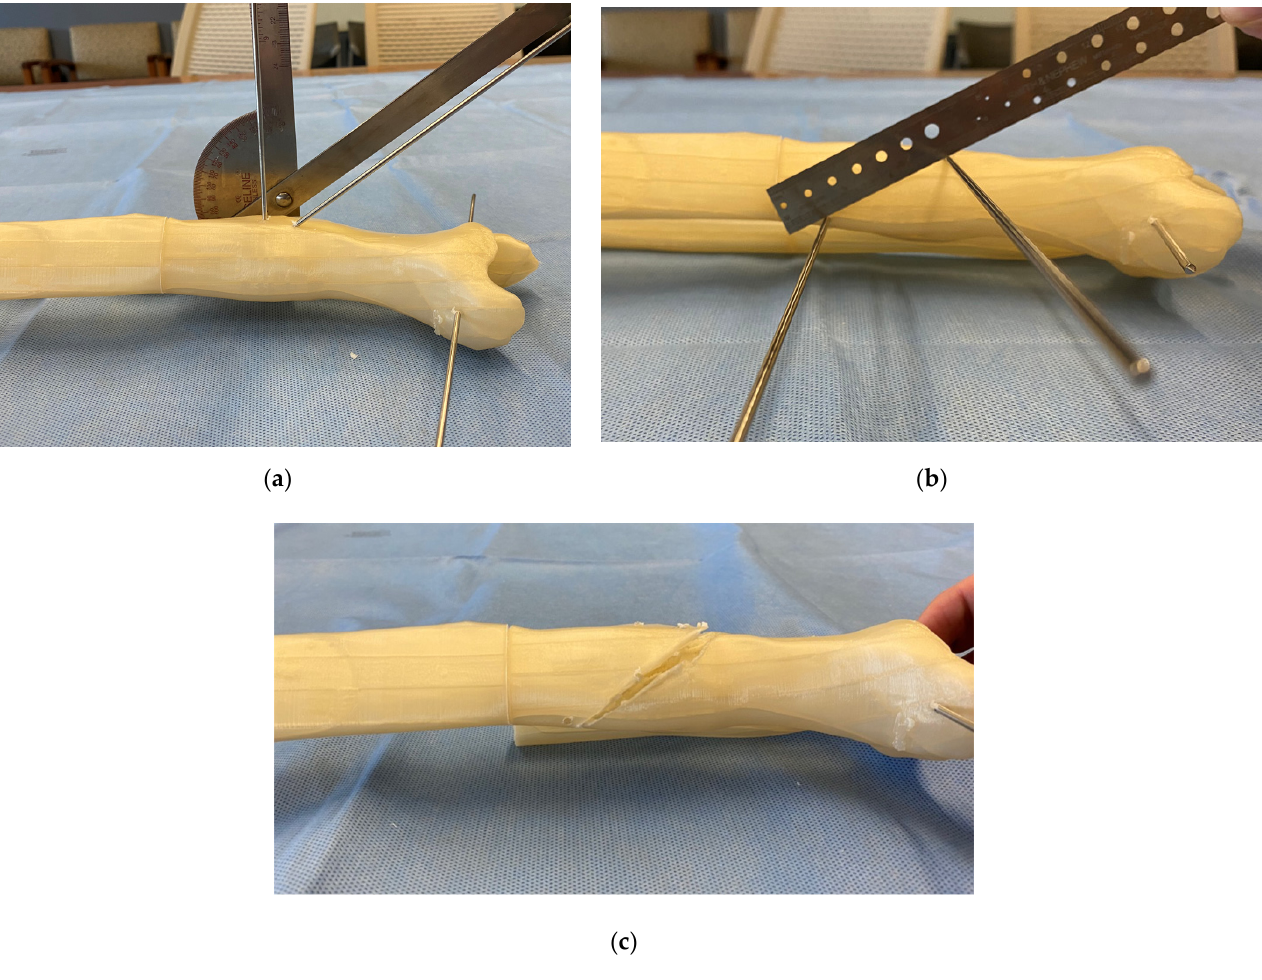
Figure 4. Osteotomy technique demonstrated on a 3D printed model. ( a ) A sterile goniometer or metal triangles are used to precisely execute the osteotomy plane based on the angles θ and φ . ( b ) Multiple K-wires are placed along the planned osteotomy to confirm the correct osteotomy plane and serve as a cutting guide for the saw blade. ( c ) Osteotomy completion and removal of the guide K-wires before rotational correction and fixation.